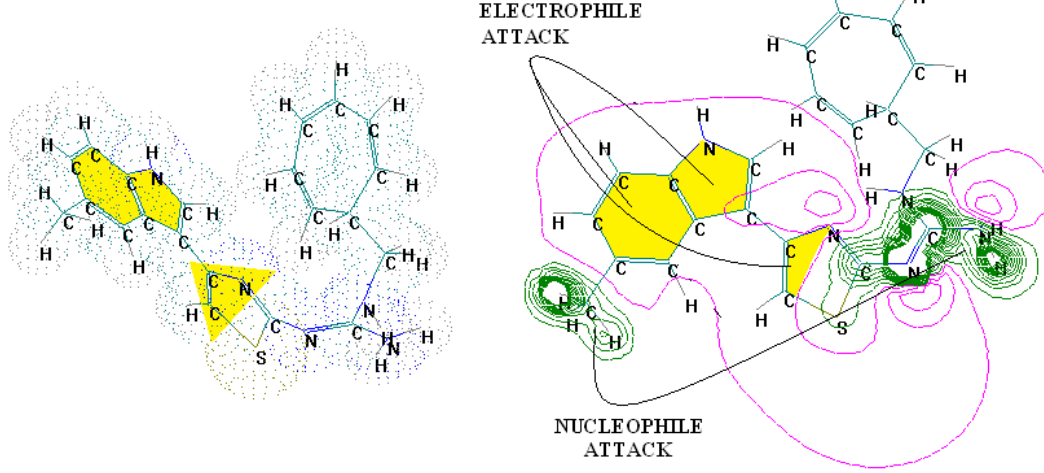
Figure 1. The electronic basins ( left ) and the associated electrostatic potential contours ( right ) for 4-(5-methylindolyl)-2-methylheptylguanidinothiazole, displaying optimized maximum electrophilic activity by the predicted special computing trace of the algebraic structure-activity relationship (SPECTRAL-SAR) mechanism action [56]. Green lines correspond with highest occupied molecular orbitals (HOMO), magenta with lowest unoccupied molecular orbitals (LUMO) with the yellow shapes marked as key fragments for chemical frontier reactivity.